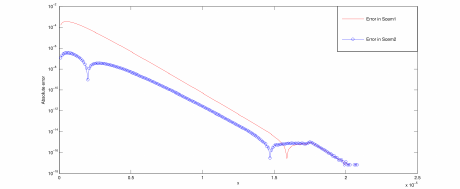
and y sceml around the 0 1